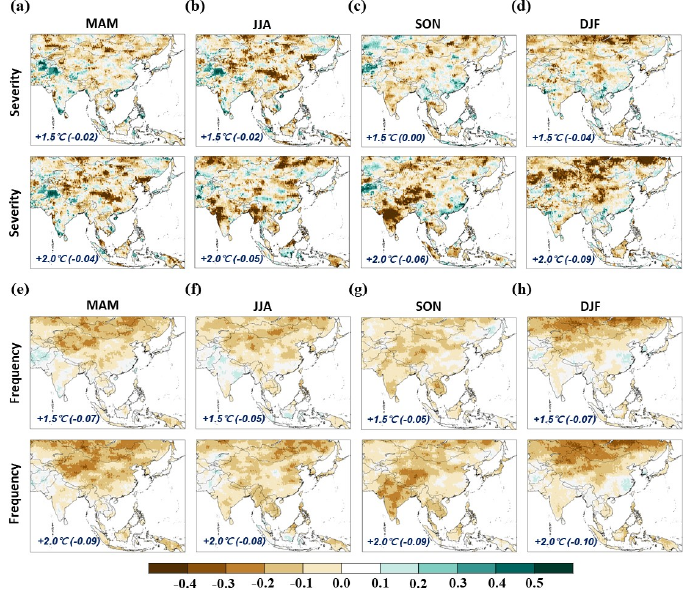
Figure 8. Spatial distribution of relative changes in the seasonal mean ( a – d ) value of severe drought; ( e – h ) frequency of severe drought (unit: times/year) based on SPI under 1.5 and 2.0 °C global warming compared to the reference period in the Asian monsoon region. The values in parentheses indicate the change in the area-averaged mean at the all grids within the domain.